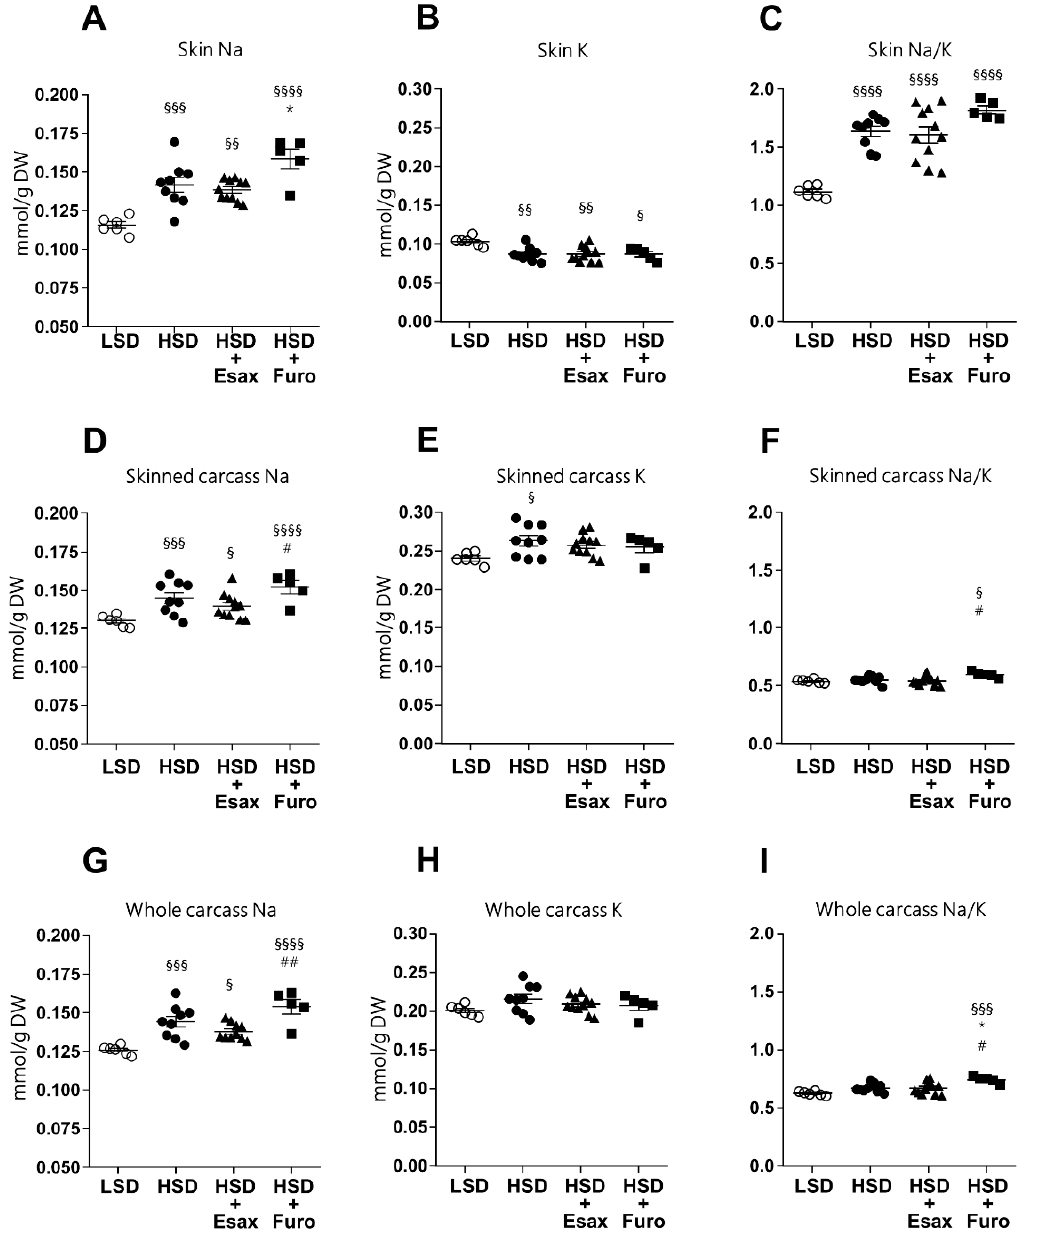
Figure 3. Skin, skinned carcass, and total body Na and K content. Skin ( A ) Na, ( B ) K, and ( C ) the Na/K ratio in the different intervention groups. Skinned carcass ( D ) Na, ( E ) K, and ( F ) the Na/K ratio in the different intervention groups. Total body ( G ) Na, ( H ) K, and ( I ) the Na/K ratio in the different intervention groups. § p < 0.05, §§ p < 0.01, §§§ p < 0.001, §§§§ p < 0.0001 vs. an LSD; * p < 0.05, vs. HSD; # p < 0.05, ## p < 0.01 vs. HSD plus esaxerenone.